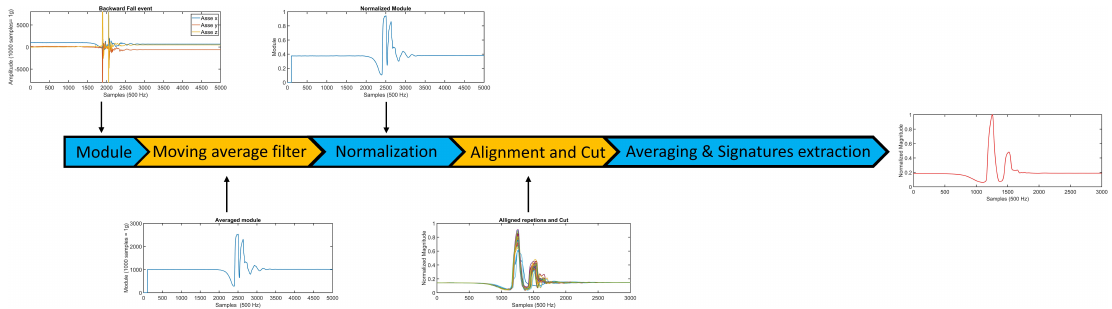
Figure 3. The procedure adopted for the signature generation. The example shows the steps for the forward fall